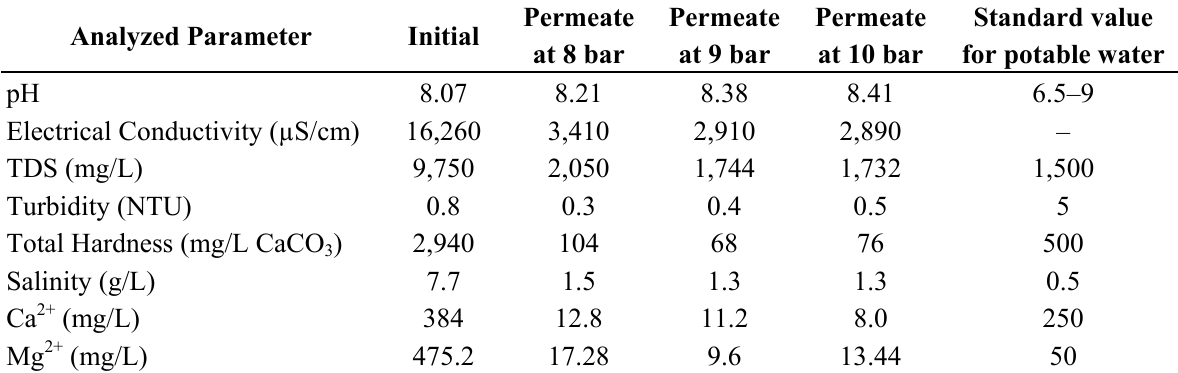
Table 1. Analysis of the feed and permeates at various pressures (Sample 1).